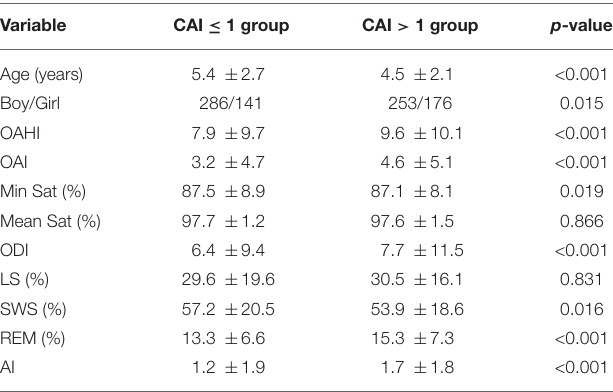
TABLE 2 | Demographic and PSG characteristic differences between the CAI ≤ 1 and CAI > 1 pediatric OSA groups.